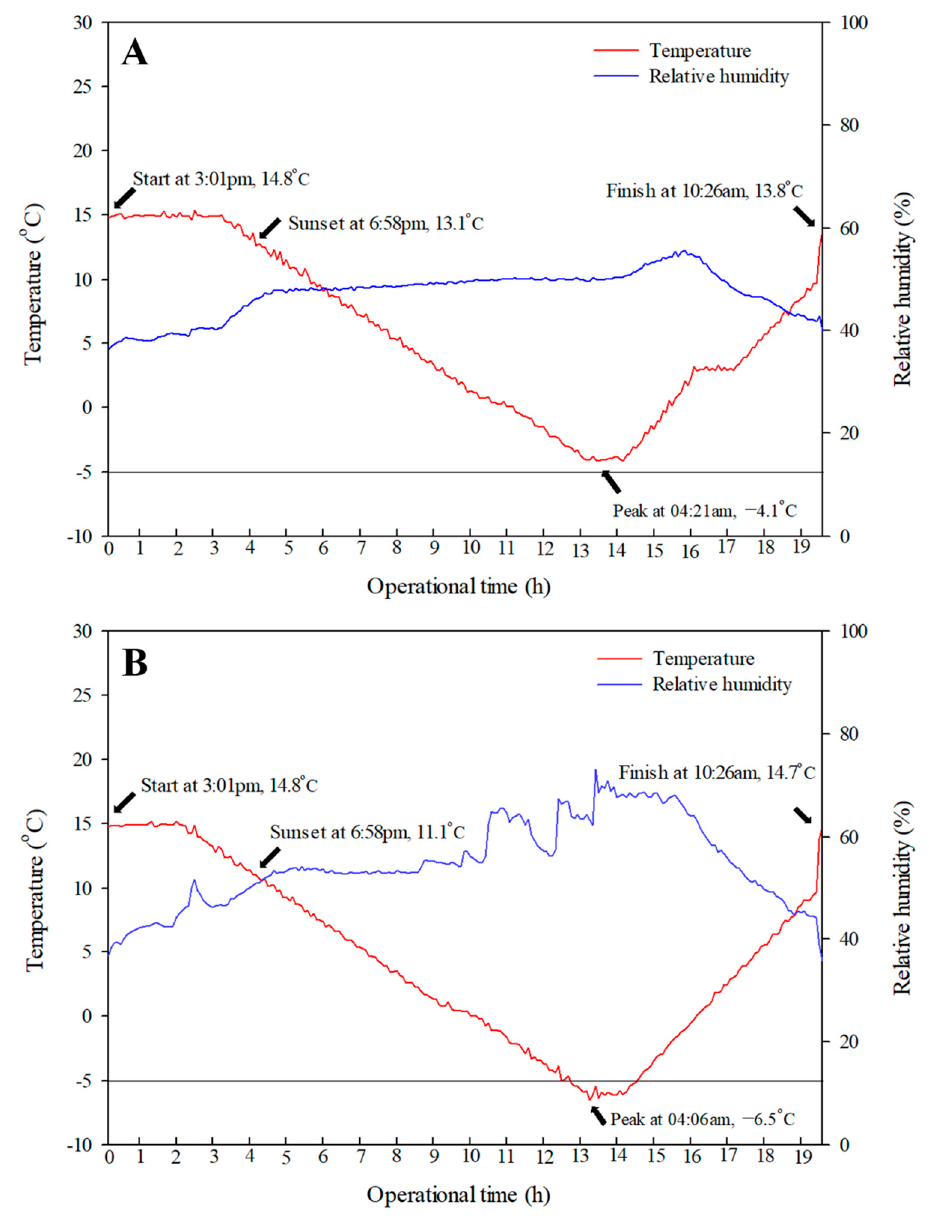
Figure 3. Changes in the temperature and relative humidity inside SFDS chambers set at the mini- mum target temperatures ( − 4 °C ( A ) or − 6 °C ( B